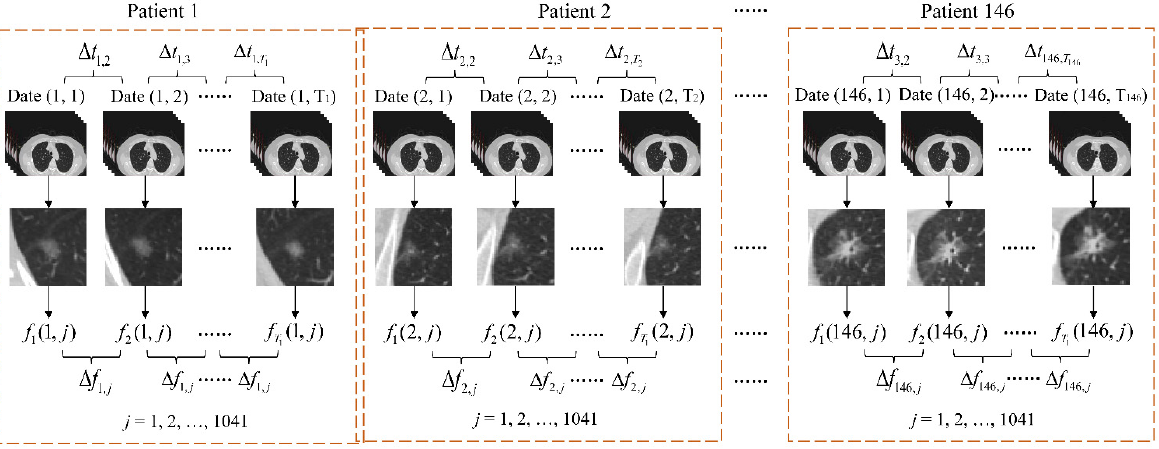
Figure 2. Feature extraction of the follow-up CTIs.